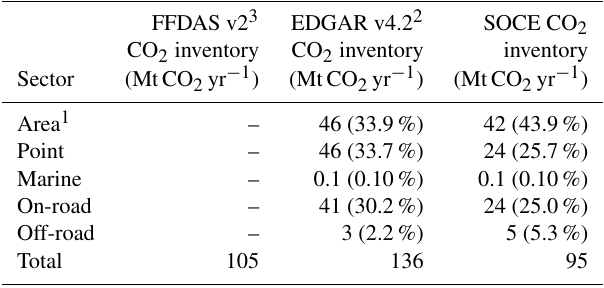
Table 2. Anthropogenic CO 2 emissions for the year 2010 in the black-box area (shown in Fig. 2a) by sector. Values in parentheses indicate the percentage contribution of the sector to the total CO 2 emissions in the black-box